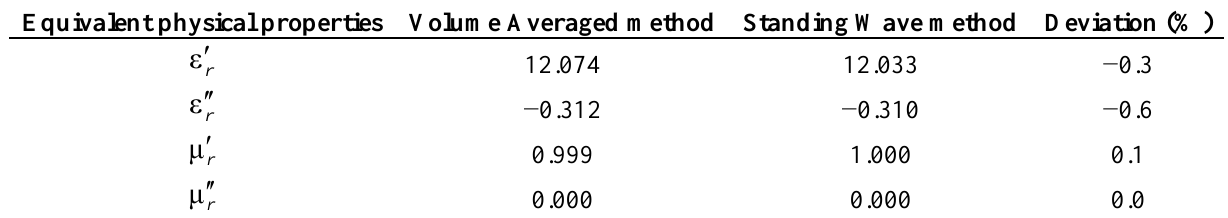
Table 4. Equivalent physical properties of particle-shaped water (water, volume rate: